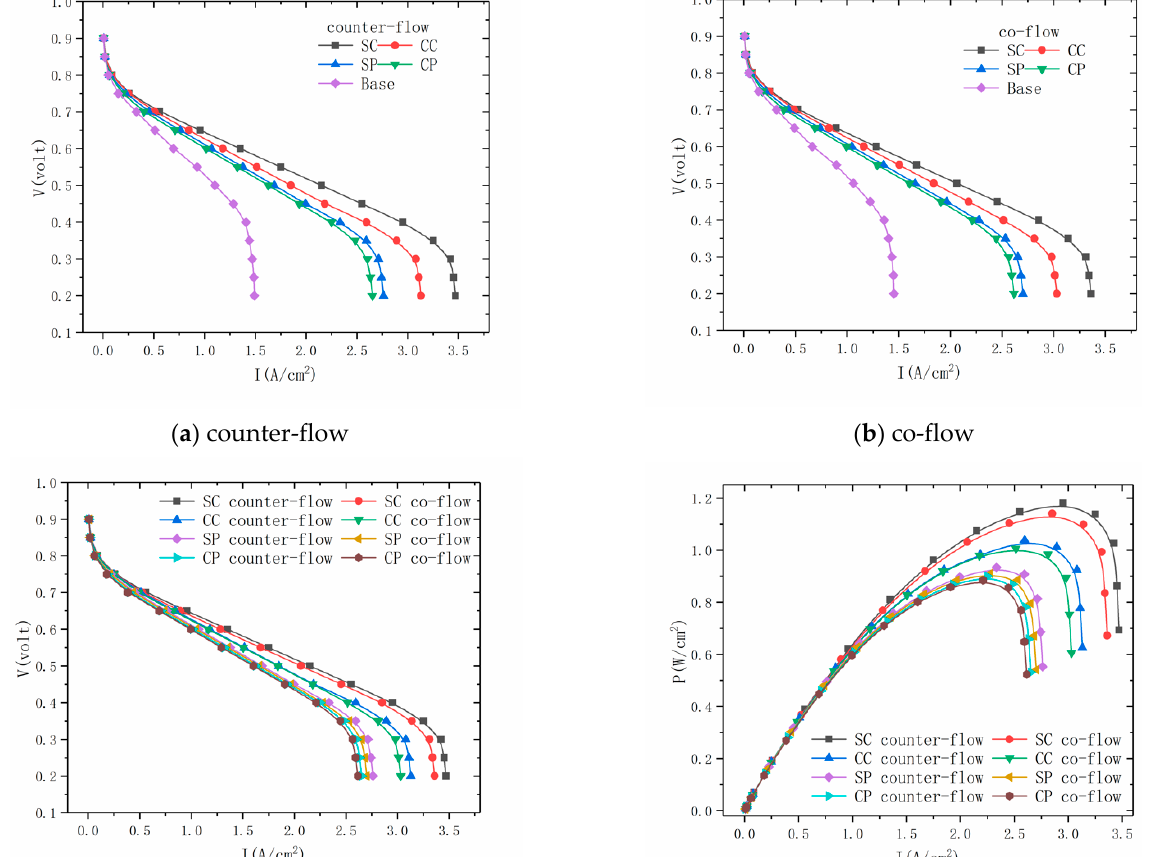
Figure 4. The results of four tubular structures with different flow patterns.